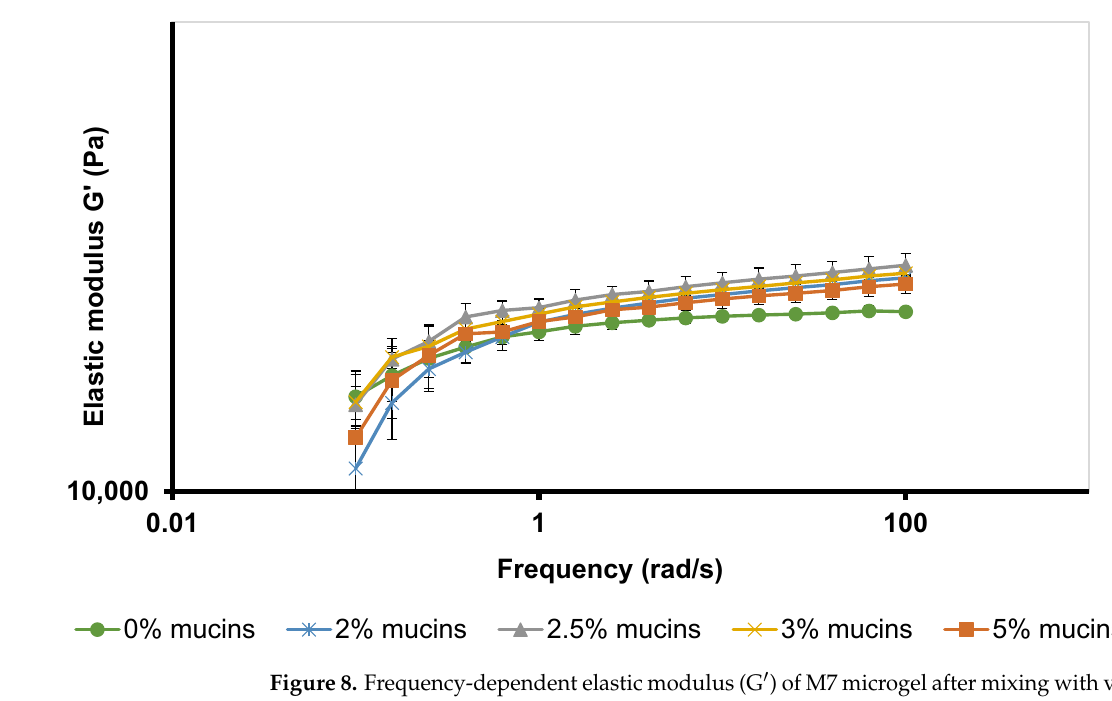
Figure 8. Frequency-dependent elastic modulus (G ′ ) of M7 microgel after mixing with various mucins concentrations at 35 °C. Table 10. Calculated mucoadhesive interaction parameter ( Δ G ′ ) of elastic modulus (G ′ ) for mucins/M 2-7 microgels mixtures and their corresponding microgels at 1, 10, and 100